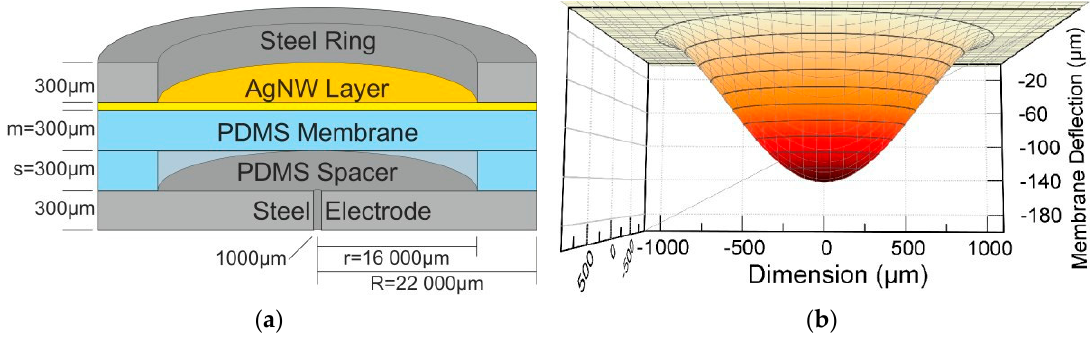
Figure 1. ( a ) Schematic cut of the actuator model showing the individual layers. ( b ) Simulation of the membrane deflection with the dimensions of the model introduced in ( a ) at an applied voltage of 700